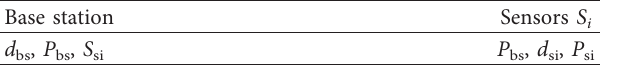
Table 2: Preloading of